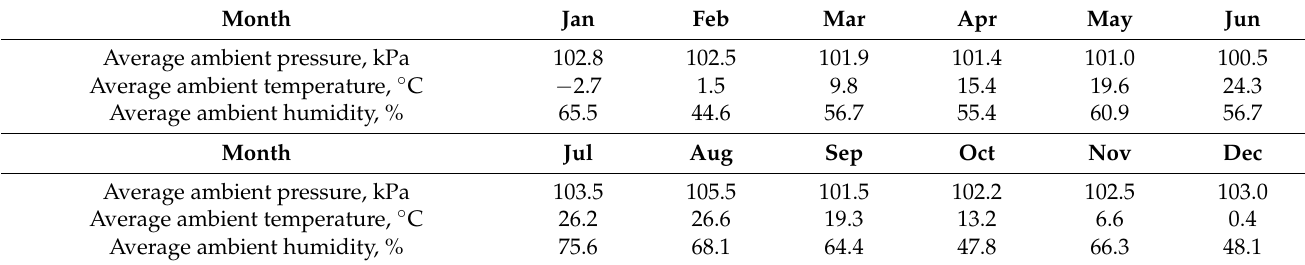
Table 5. Weather conditions of Yangcheng in North China during 2018.